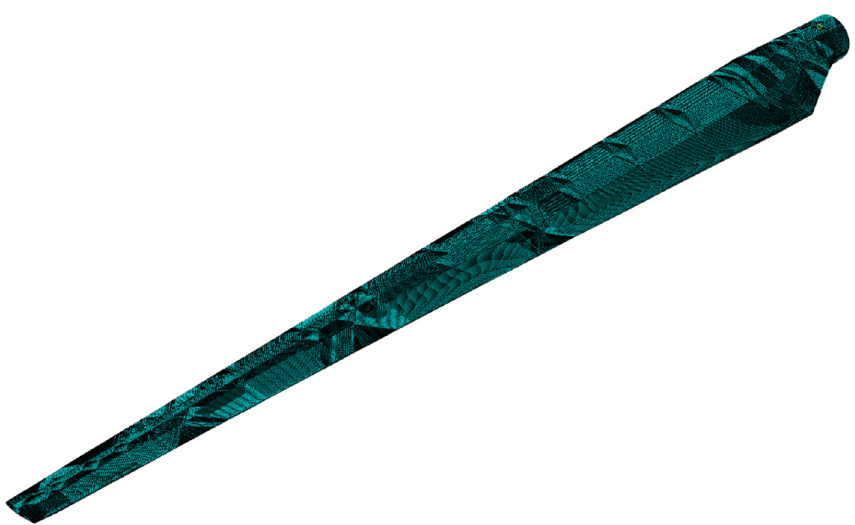
Figure 7. The meshed FE model generated in ABAQUS.